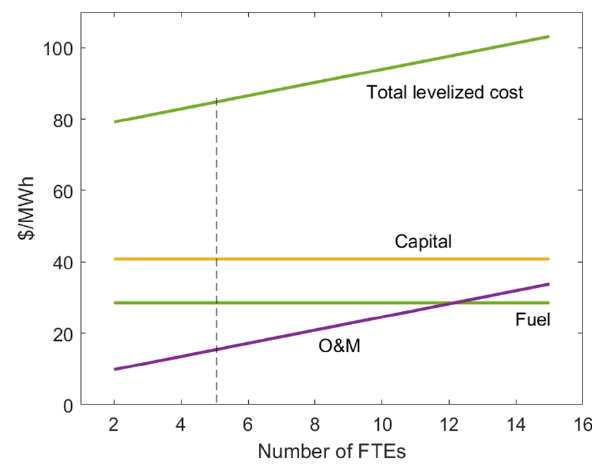
Figure 13. NB levelized electricity costs vs. FTEs.